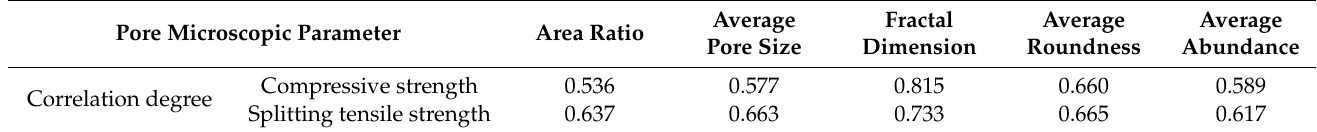
Table 5. The correlation value of pore structure with